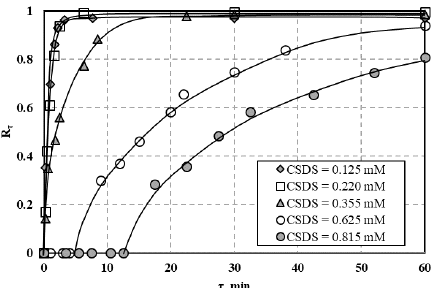
Figure A15. Changes in Zn(II) temporary removal ratio during precipitate flotation from solution containing Al(III), Cu(II), and Zn(II) mixture—effect of collector concentration (c 0 = 0.15 mmol dm − 3 , pH = 8.0, u G = 1.51 mm s − 1 ).